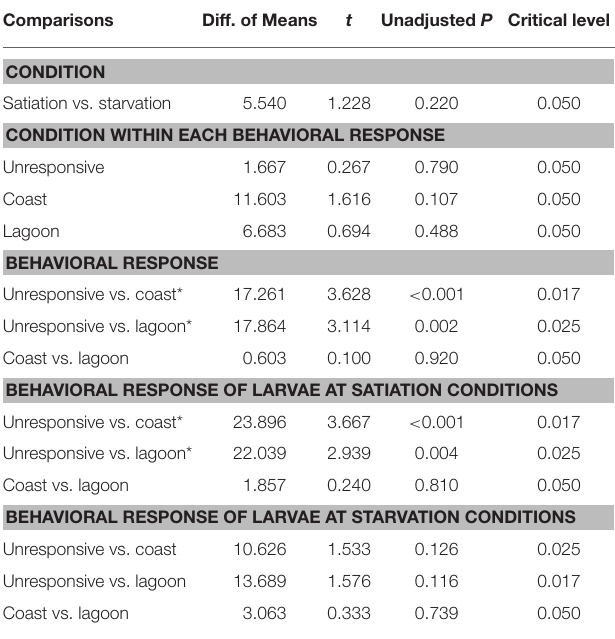
TABLE 5 | Multiple comparisons’ statistical output for the Minimum Consecutive Time (MinCT) index calculated for all post-flexion